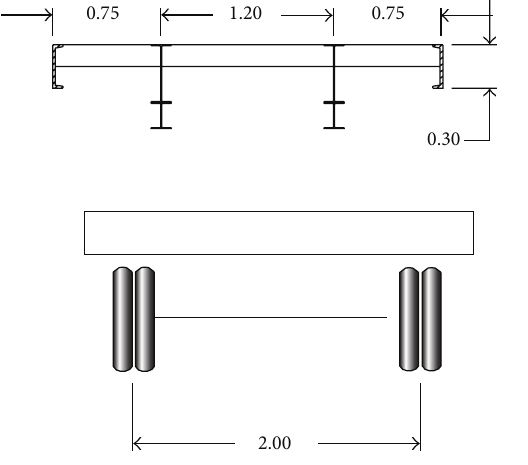
Figure 8: Mean acceleration of bridge at the midspan.